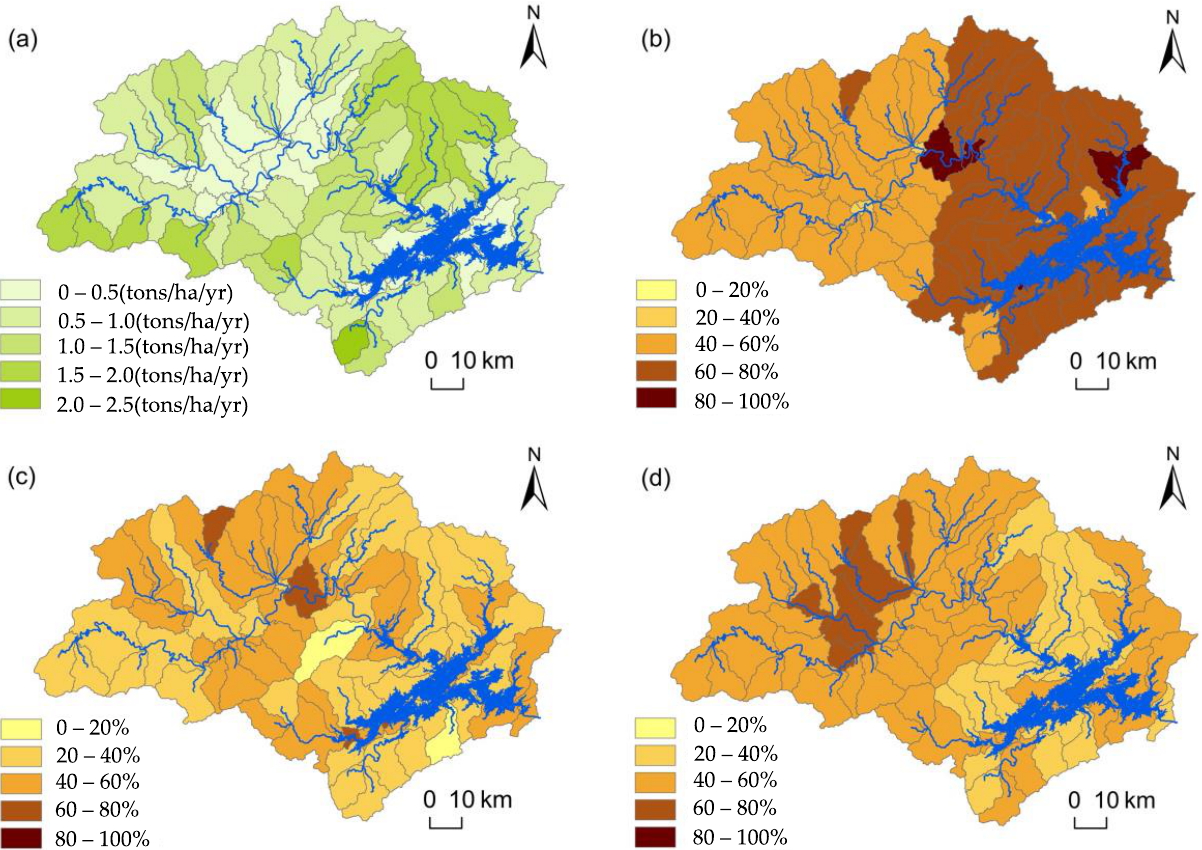
Figure 7. The spatial characteristics of annual sediment yield in XRB. ( a ) The mean annual sediment yield of every sub-basin in the baseline period. ( b ) The relative changes in the sediment yield between RCP2.6 and baseline. ( c ) The relative changes in the sediment yield between RCP4.5 and the baseline. ( d ) The relative changes in the sediment yield between RCP8.5 and the baseline.